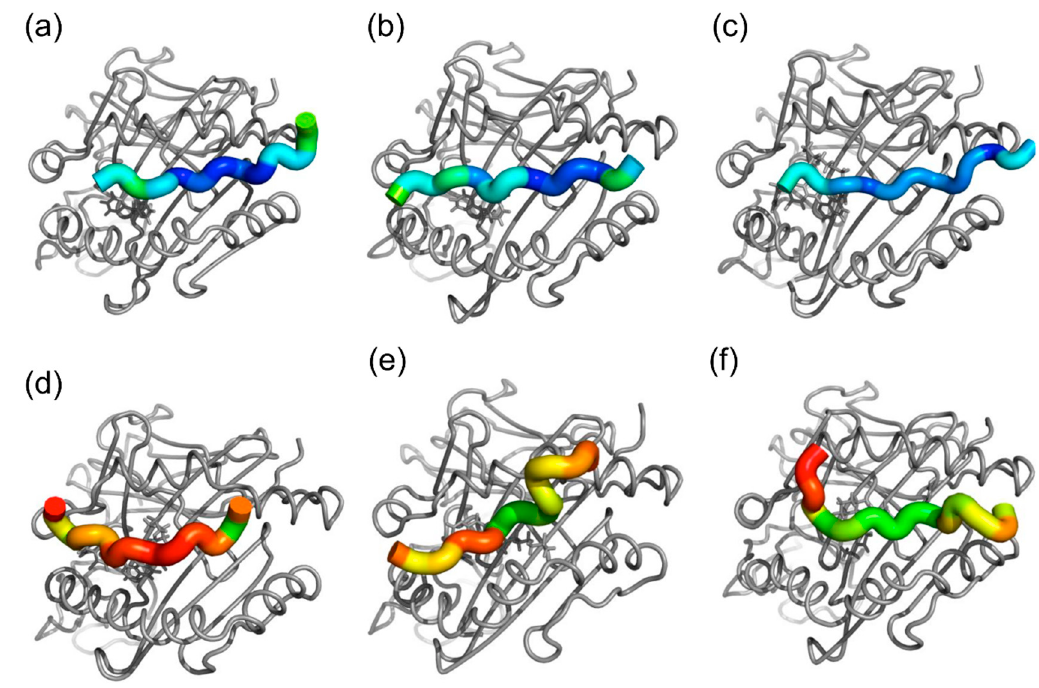
Figure 5. Drug-induced peptide displacements in ( a ) nevirapine-bound HLA-DRB1*01:01-HA peptide in frame 2 and ( b ) frame 3; ( c ) lapatinib-bound HLA-DRB1*01:01-HA peptide in frame 2 ( d ) and frame 3; ( e ) lapatinib-bound HLA-DRB1*07:01-peptide from tetanus toxoid (TT) in frame 3; and ( f ) ximelagatran-bound HLA-DRB1*07:01-TT peptide in frame 3. Each residue in the ligand peptides is colored according to the displacement of the C α in the trimer simulations, relative to its position in the HLA-peptide dimer simulations. The same color scale is used and the range is from 0 ( blue ) to 10 Å ( red ). Small values mean that the drug has little effect on the position of ligand peptides in the binding groove. Drugs are shown using grey stick representation.